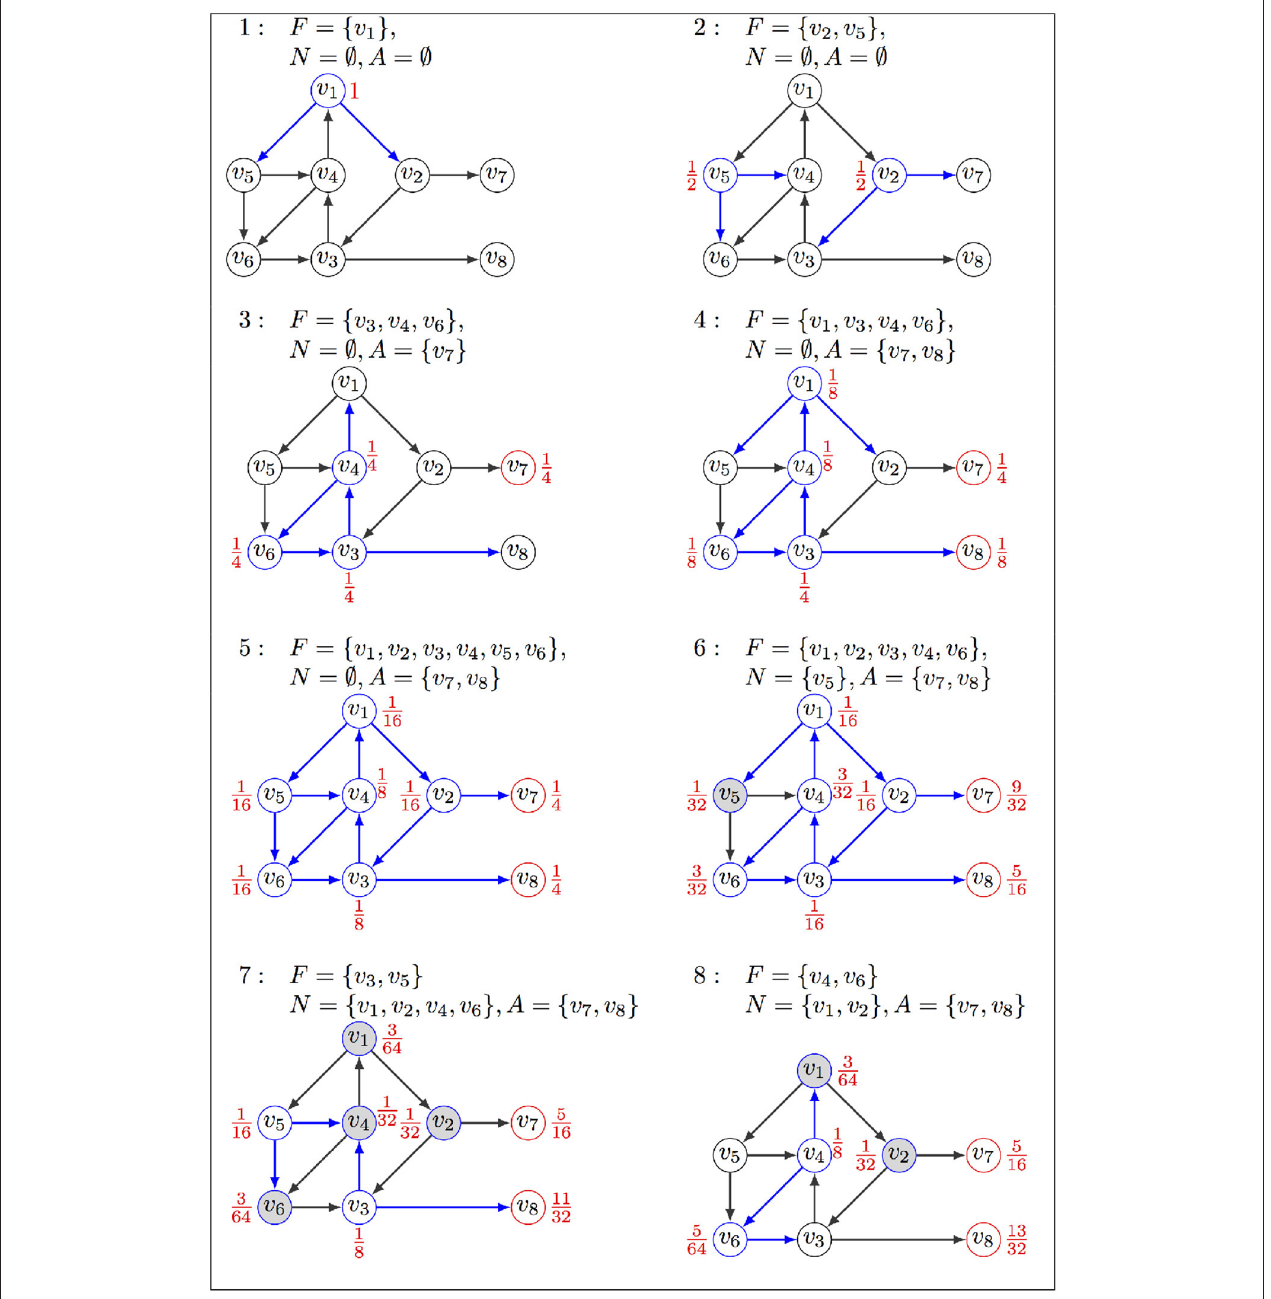
FIGURE 1 | Illustration of FIREFRONT operation, with α = 1 16 : (1) The exploration starts from initial state v 1 in F associated with probability 1, sets A and N are empty; (2) successors replace v 1 in F , associated with their probabilities; (3–4) states in F are replaced by their successors, but the stable state v 7 goes in A ; (4) v 3 , v 4 , v 6 stay in F with updated probabilities; (5) probability of v 8 in A increases as it is visited again; (6) v 5 goes to N as its probability is lower than α ; (7) v 5 is removed from N and put back in F as its probability increased when visited again from v 1 . Transitions explored in the current iteration are in blue, their sources being labeled with their probabilities. Red nodes are in A , and gray nodes are in N . The exploration will halt when F is empty or the maximum number of iterations is reached.